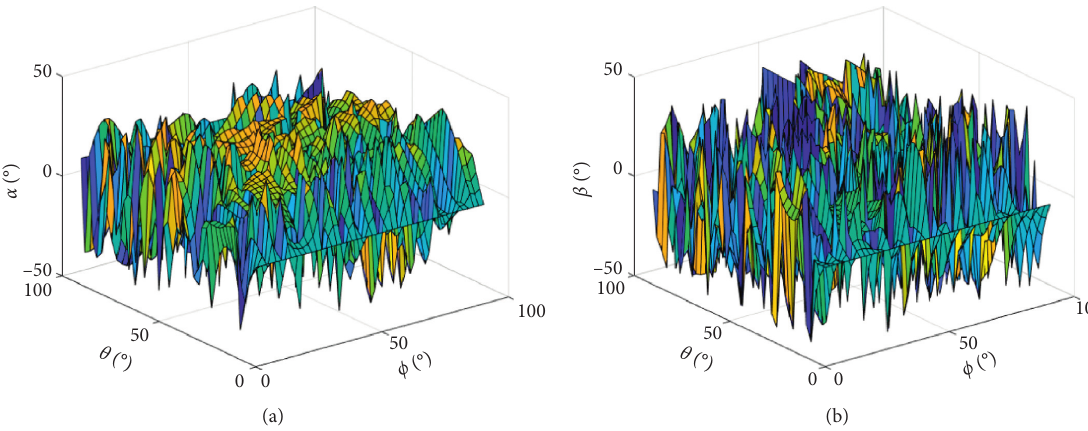
Figure 8: The surface of polarization parameter pair using the proposed method. (a) Orientation angle. (b) Ellipse angle.